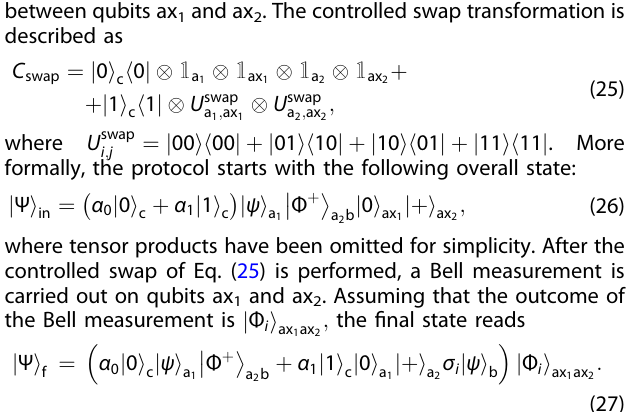
Algorithm 1 . Controlled measurement. Input: Known state φ j i